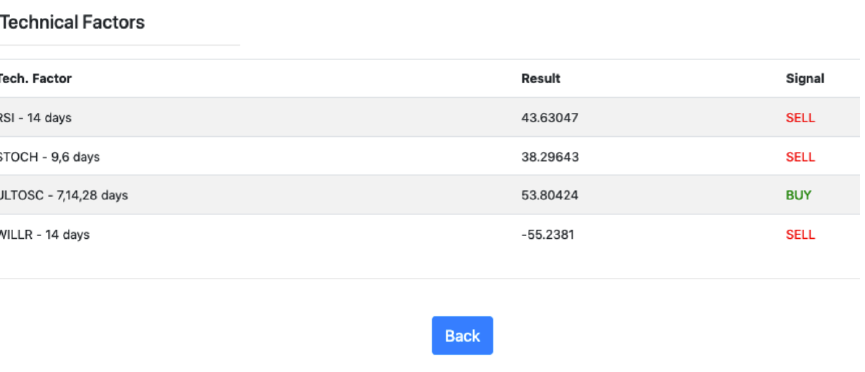
Figure 18. Regression Algorithms Accuracy Check.